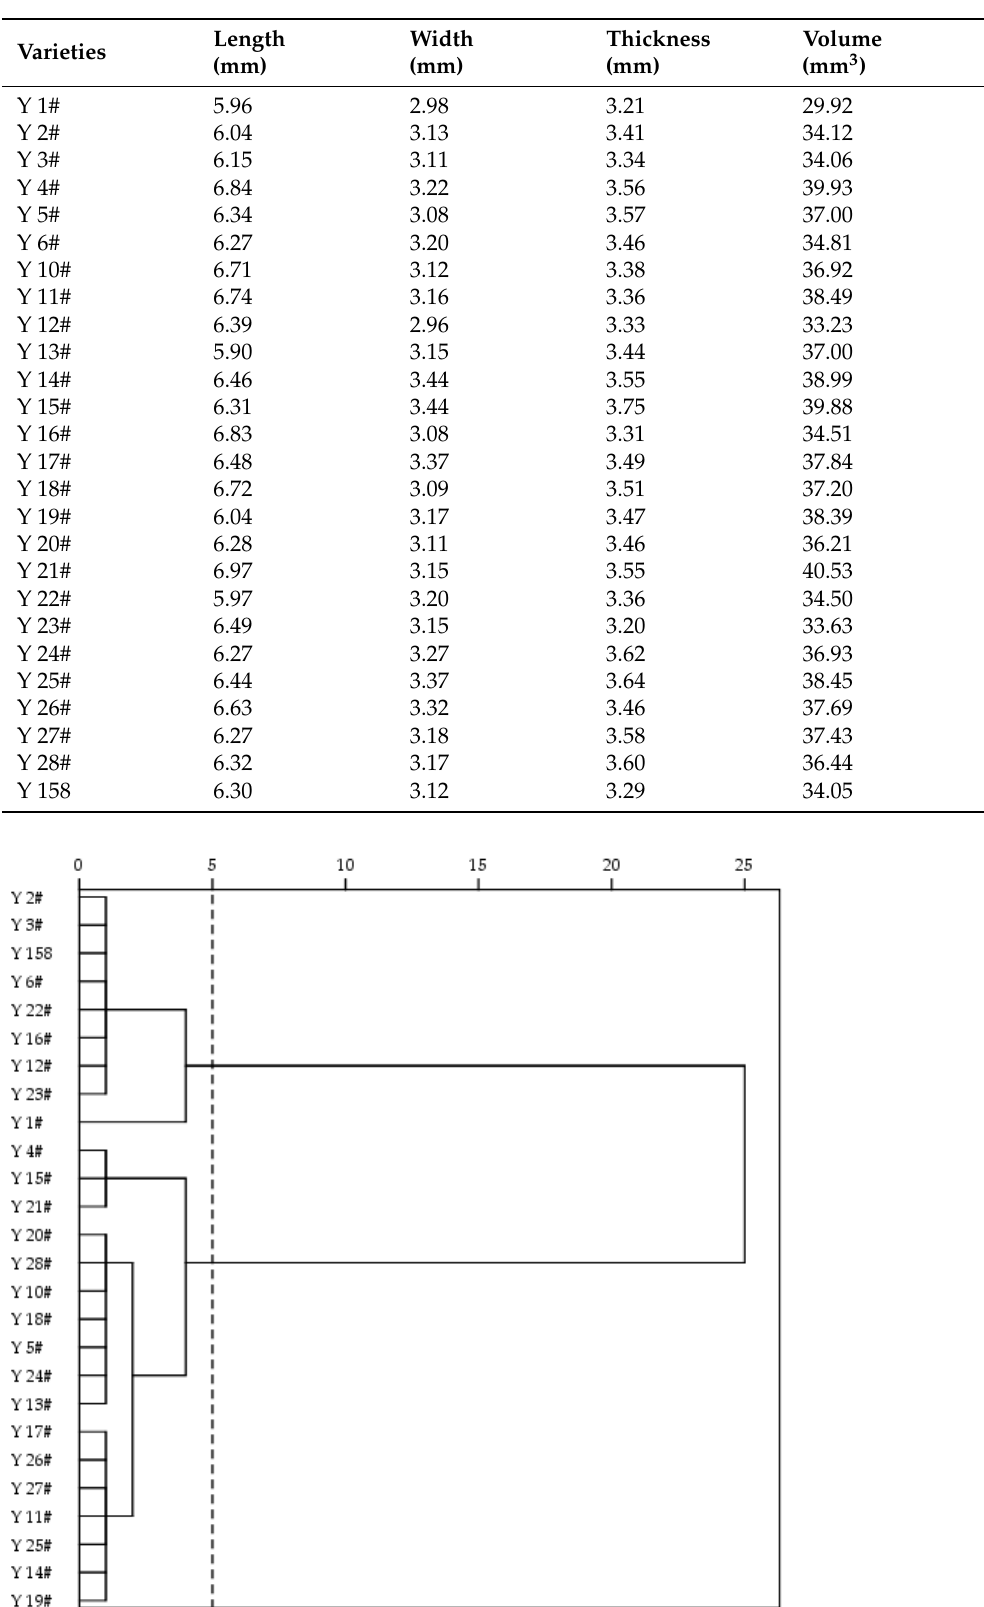
Table 5. Mean value of 3D morphological indicators of Yangmai series varieties.